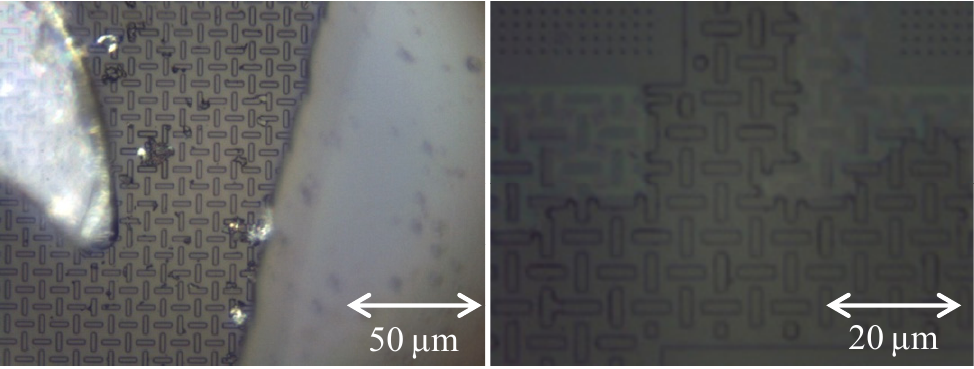
Figure 1. Optical images of the generated resist based defects on the template in nanoimprint